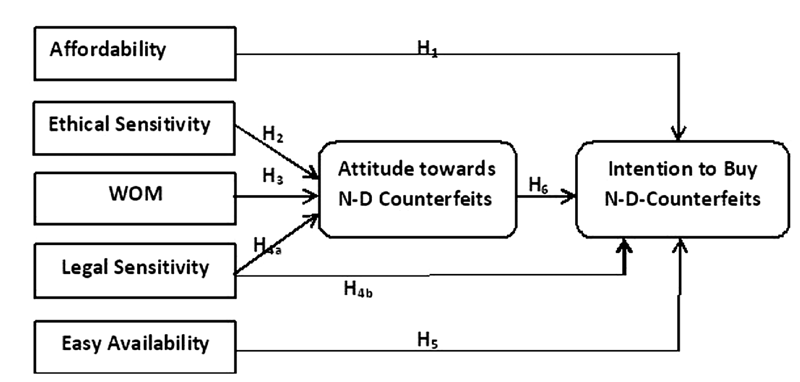
Fig. 1. Proposed model of attitudinal and intentional predictors of non-deceptive